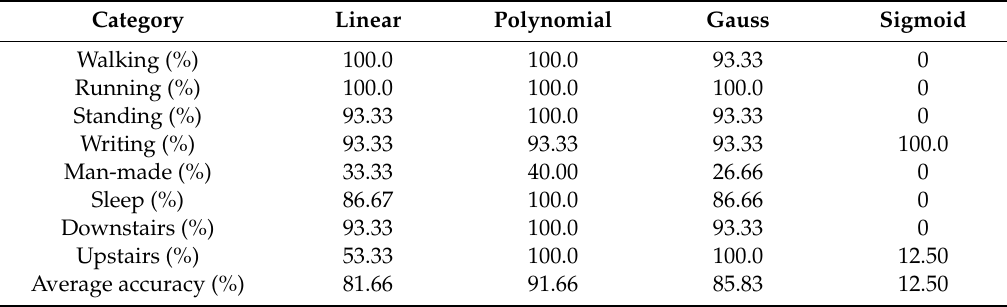
Table 5. Relief-F-SVM kernel function classification accuracy.